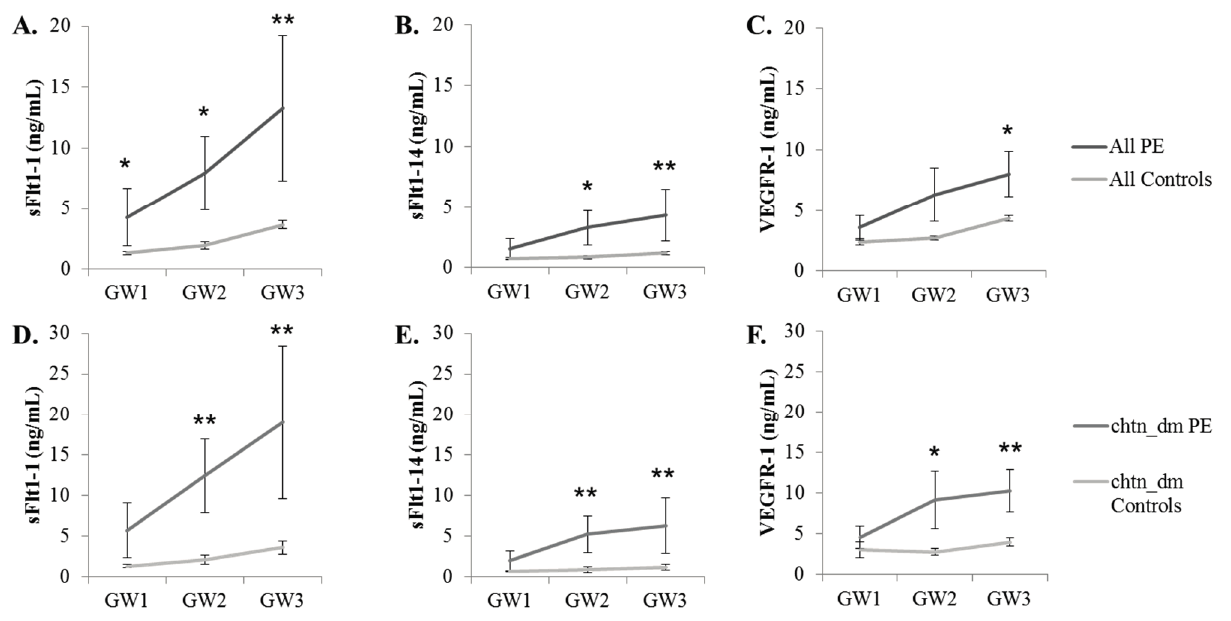
Figure 5. sFlt1 isoform and VEGFR-1 quantitation from serum samples at three